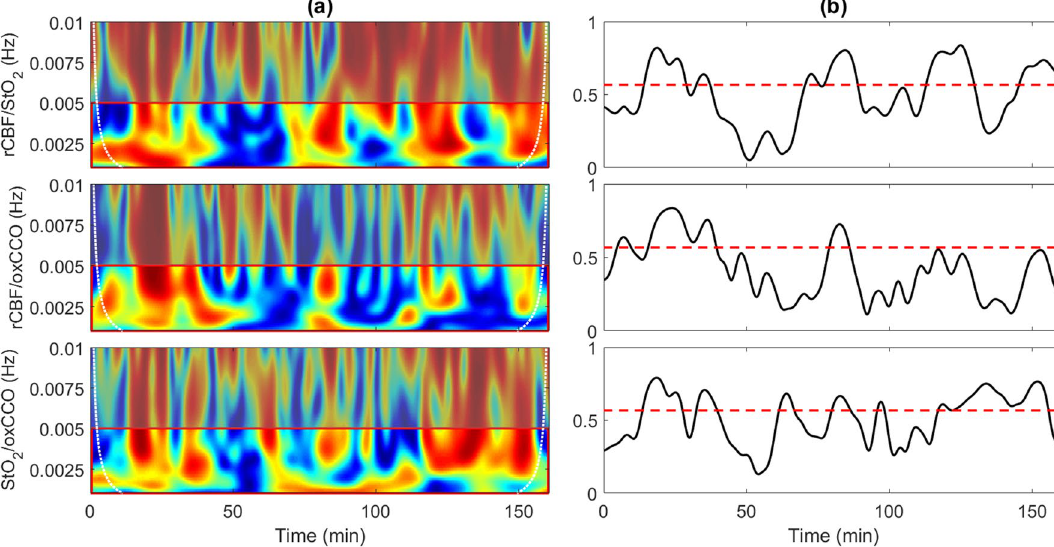
Figure 3. ( a ) Coherence between rCBF and StO 2 , rCBF and oxCCO, and StO 2 and oxCCO for one patient on the first day of life. ( b ) Average coherence value in the frequency range 0.001−0.005 Hz. The red dashed line indicates the statistical threshold.